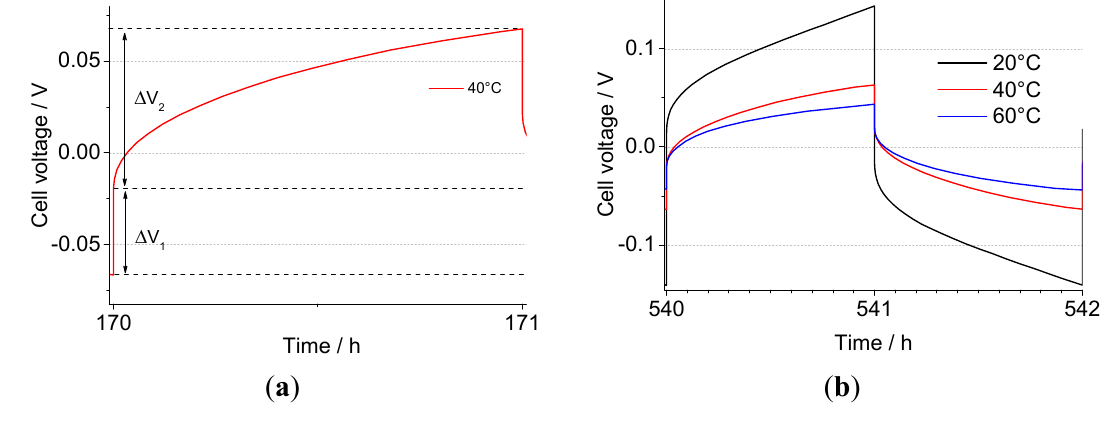
Figure 3. ( a ) Illustration of the quantities, Δ V ( b ) comparison of the voltage profiles for cells thermally conditioned for 168 h (one week) at different temperatures, as indicated on the